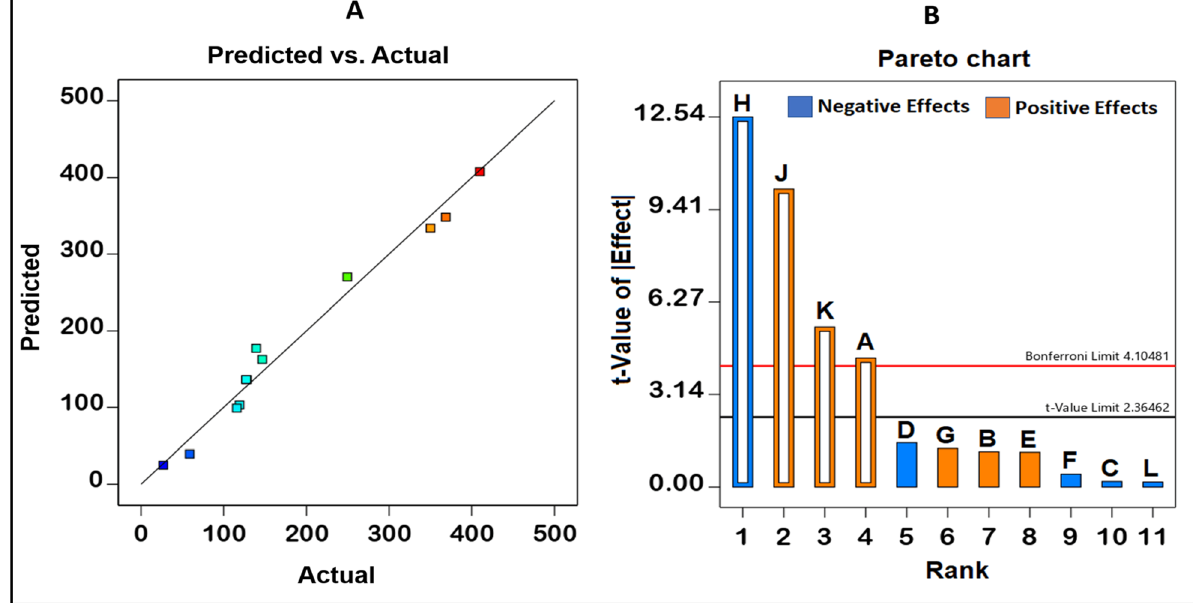
Figure 5. Plackett–Burman design for Kocuria sp. RAM1 carotenoids optimization. ( A ) Carotenoids yield predicted value versus experimental value. ( B ) PBD factors that influence carotenoids yield. The orange and blue bars are corresponding to the positive and negative effect, respectively. A: Peptone (g/l), B: Yeast extract (g/l), C: Beef extract (g/l), D: NaCl (g/l), E: Glucose (g/l), F: MgSO 4 (g/l), G: pH, H: Temperature, J: Agitation (rpm), K: Inoculum size (%), L: Incubation period